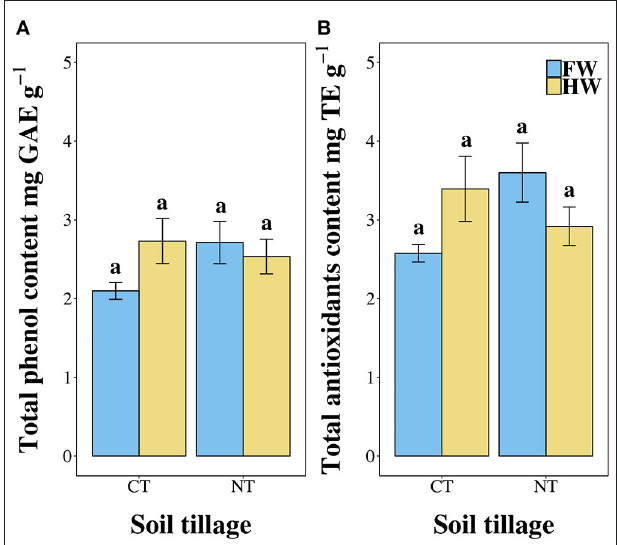
FIGURE 1 | (A) Total phenol content (expressed as gallic acid equivalents per gram of dry leaves), (B) total antioxidants content (expressed as Trolox equivalents per gram of dry leaves) of jute mallow plants grown under the four different agronomic treatments. Data are expressed as the mean ± SEM. CT, conventionally tilled; NT, not-tilled; FW, fully watered; HW, half-watered.